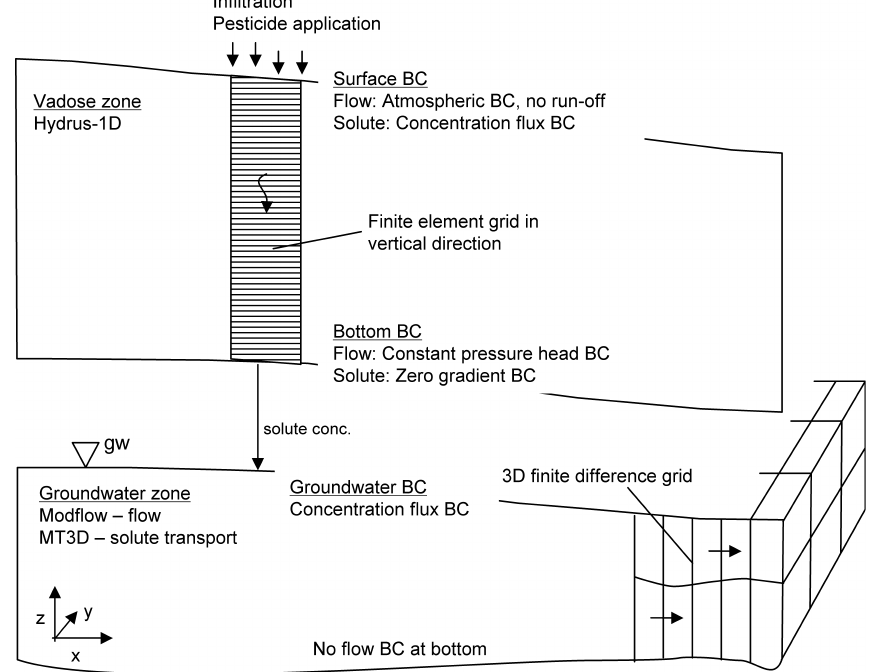
Fig. 1. Modeling procedure and boundary conditions (BC) of water flow and solute transport. The vadose zone model was run only for the contaminated nursery